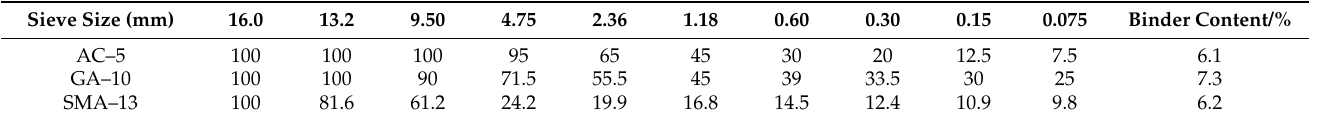
Table 2. Aggregate gradation of the three mixtures.